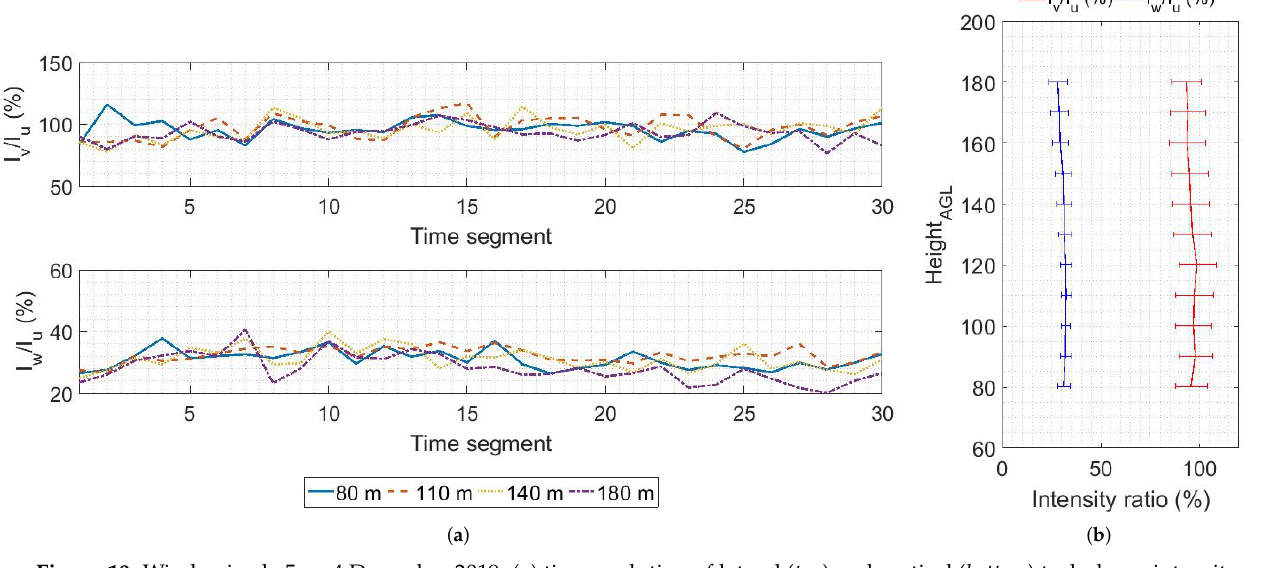
Figure 10. Wind episode 5 on 4 December 2019: ( a ) time evolution of lateral ( top ) and vertical ( bottom ) turbulence intensity as a percentage of the along-wind intensity component at four different heights above the ground. Each time segment represents a 10 min interval; ( b ) mean vertical profile of the ratio between turbulence intensity